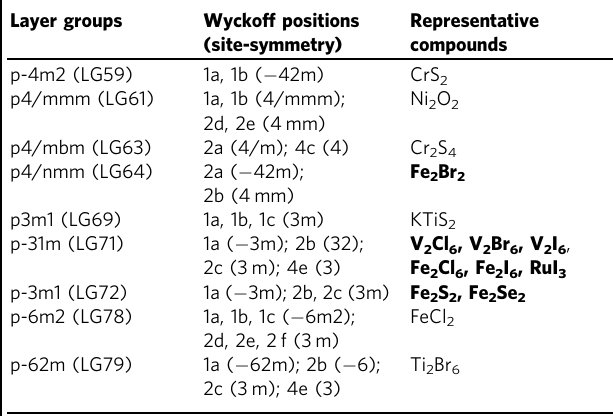
Nine material candidates of high-temperature quantum anomalous Hall insulators are marked